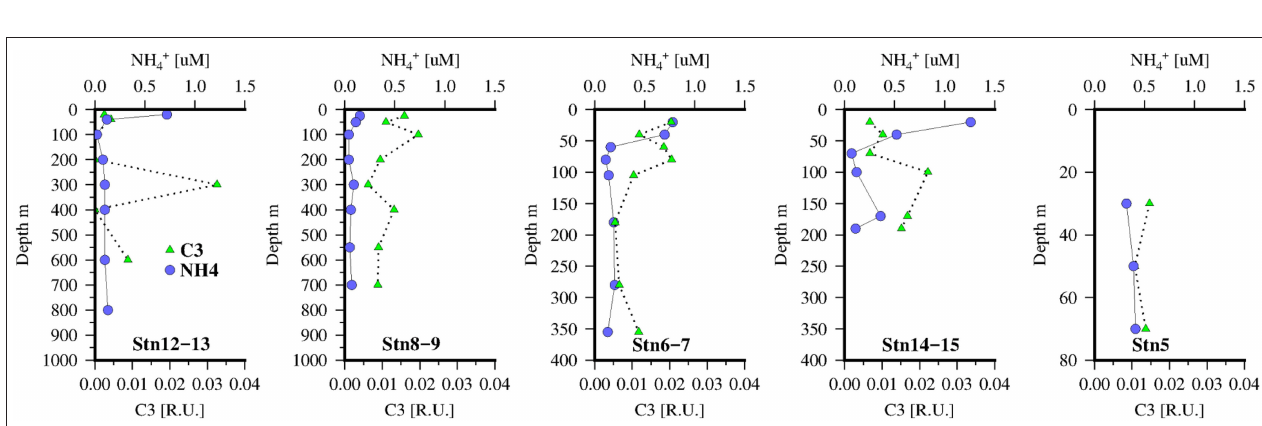
FIGURE 5 | FDOM humic-like components identified by PARAFAC, C1(green triangles), and C2(blue circles) at 5 stations along the transect in the Mauritanian Upwelling.